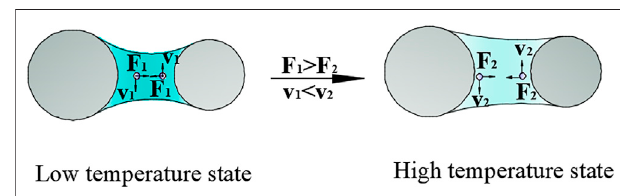
FIGURE 8 | Molecules velocity and intermolecular interaction forces between tailings particles at different temperatures.